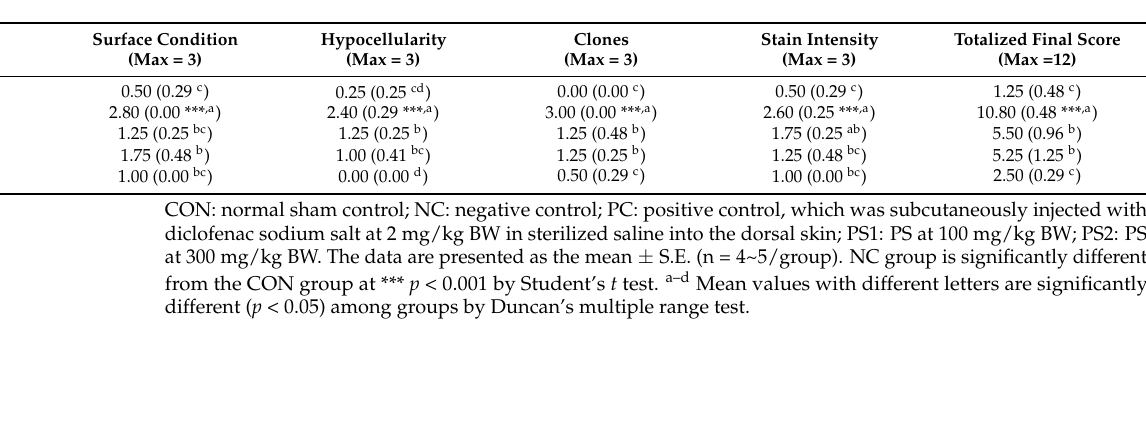
Table 6. The effects of PS on histomorphometrical data obtained by the Mankin scoring systems on